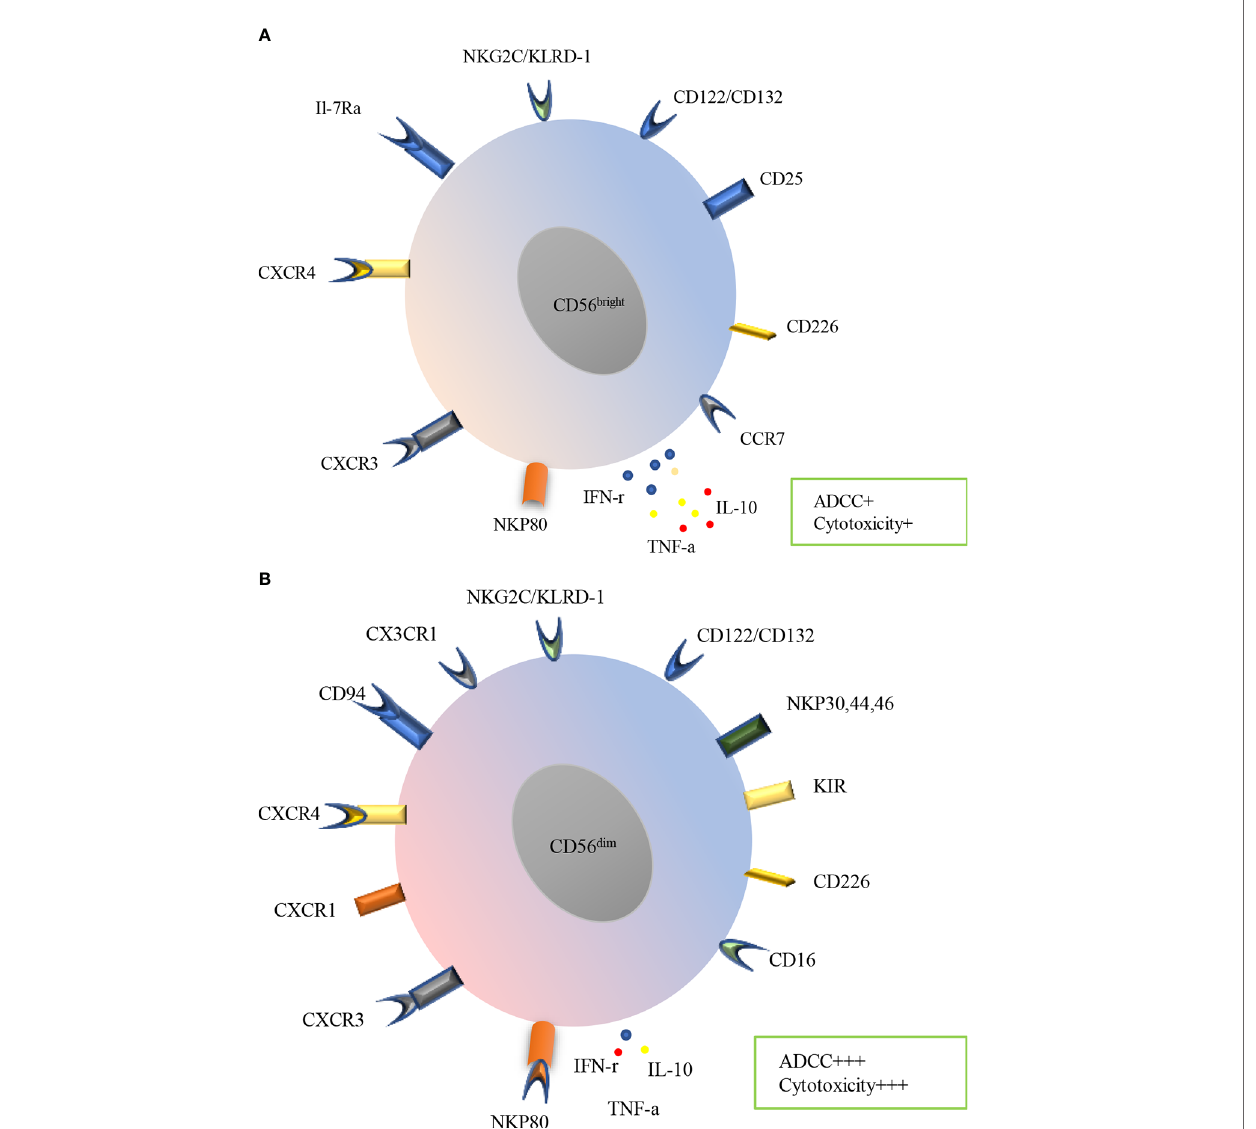
FIGURE 2 | Surface receptors and functions of PB human NK cells subtypes. Human NK cells are divided into CD56 bright (A) and CD56 dim (B) subsets in PB, which express a variety of receptors, including inhibitory, activating, cytokine, chemokine receptors and death receptors. CD56 bright subset mainly expresses CCR7, CD226, CD25, CD122/132, NKG2C/KLRD-1, IL-7Ra CXCR4, CXCR3and NKP80, meanwhile, CD56 dim subset mainly expresses CD16, CD226, KIR, NKP30, NKP44, NKP46, CD122/CD132, NKG2C/KLRD-1, CX3CR1 CD94, CXCR4, CXCR1, CXCR3. CD56 bright subset produces more IFN- g , TNF- a and IL-10 while less ADCC and cytotoxicity. In contrast, CD56 dim subset produces less cytokines, however prominent ADCC and